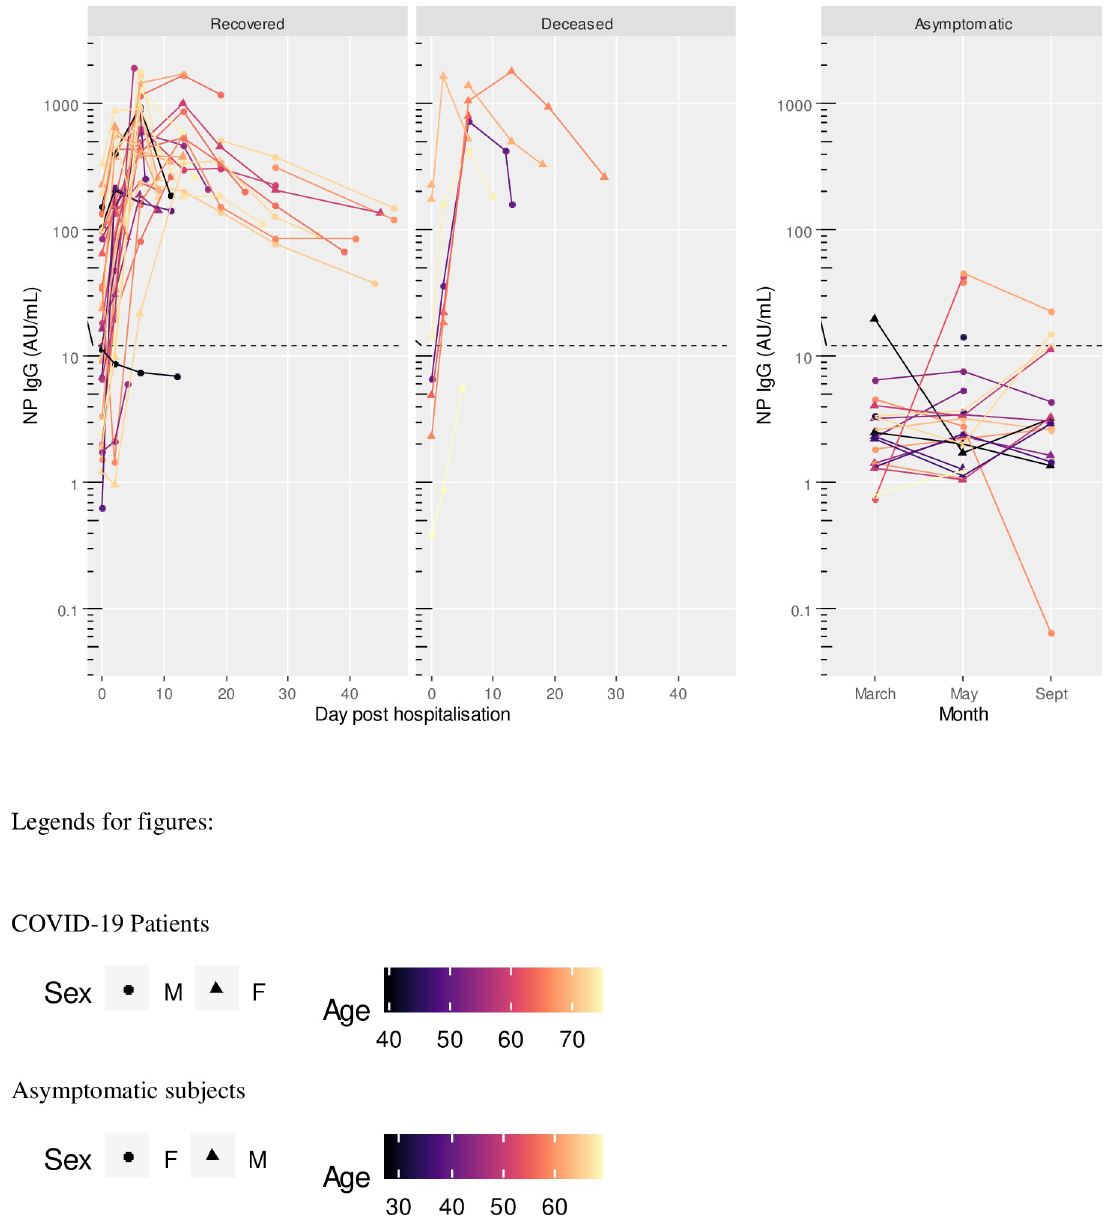
Fig 4. NP IgG titres in COVID-19 patients (recovered and deceased) and asymptomatic subjects. Black dashed line indicates positivity threshold at 12 U/ml. Neutralizing antibodies well correlated with all ELISA antibodies tested (r = 0.722 with S1 IgA, r = 0.798 with S1 IgM, r = 0.739 with S1 IgG, and r = 0.730 with NP IgG).